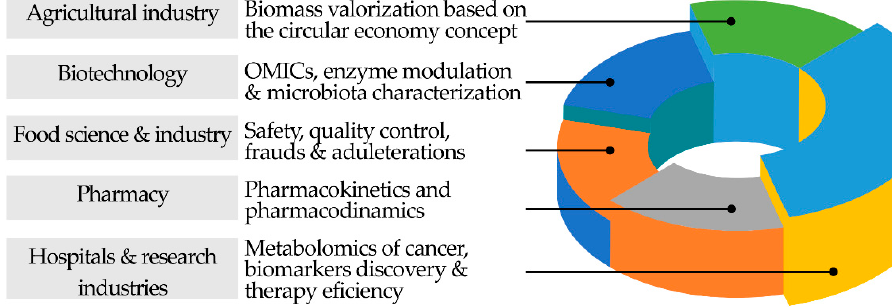
Figure 4. Important applications fields of chromatography in science development.